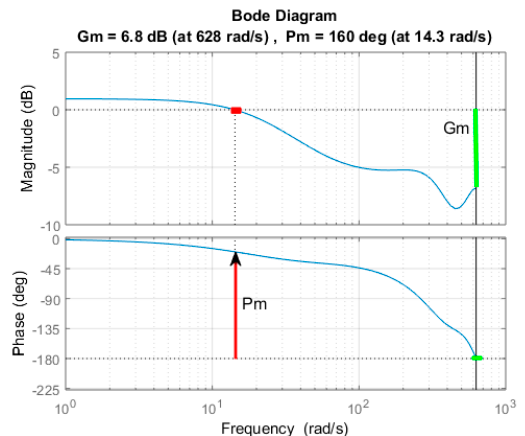
Figure 16. The frequency domain characteristics of the control system—Bode diagram.